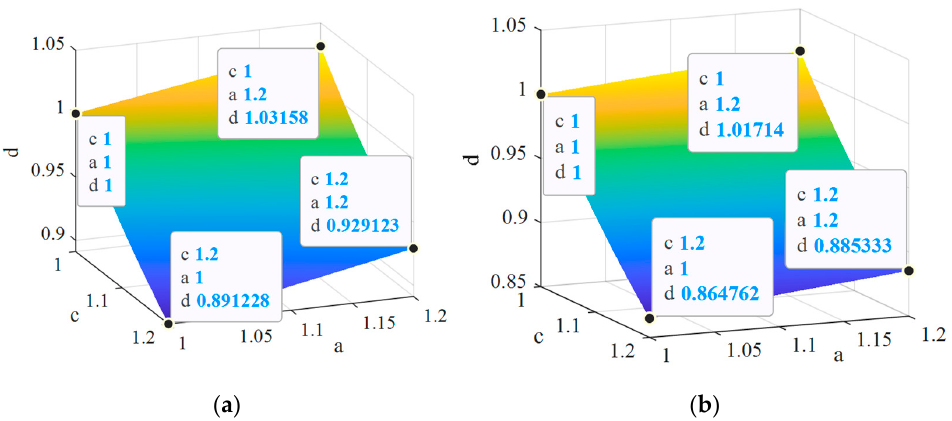
Ω , R = 2 P = 800 W; o o